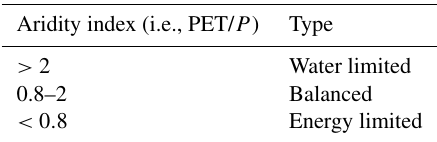
Table 1. Classification of the aridity